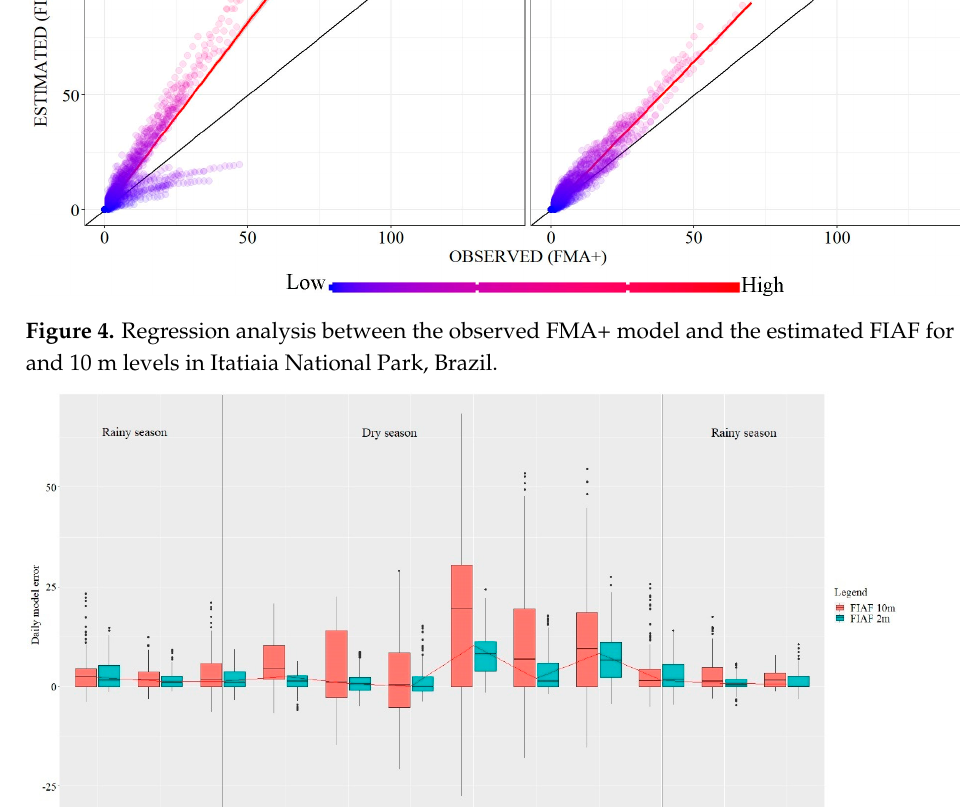
Figure 5. Daily temporal analysis of the error associated with the FIAF model for the 10 and 2 m levels, highlighting the two seasons in the southeast region (dry and rainy) for the Itatiaia National Park, Brazil.